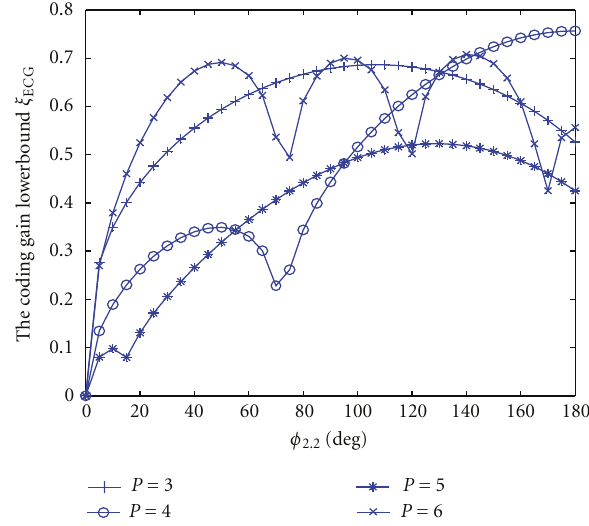
Figure 3: ˘ ξ ECG of rate one MRP versus rotation angle φ 2,2 for a MIMO-OFDM system with δ = (cid:6) 512 /P (cid:7) , N t = 2, N c = 512, and given COST207 typical urban six-ray power delay profile.